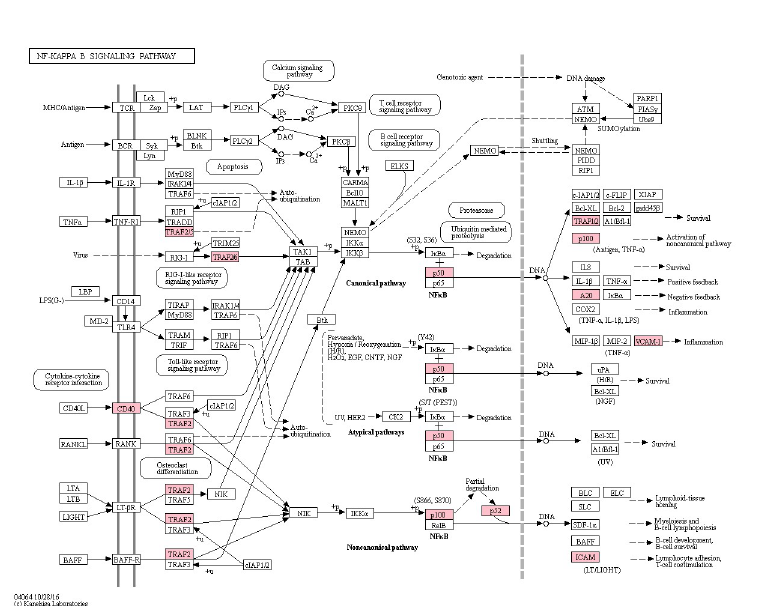
Fig 3. Putative changes in the NK- κ B signalling pathway induced by sPIF treatment. Red boxes are proteins encoded for by DEGs, with reduced expression following sPIF treatment, as identified by STRING analysis, based on P adjusted values ( P adj = 5.5 x 10 − 7